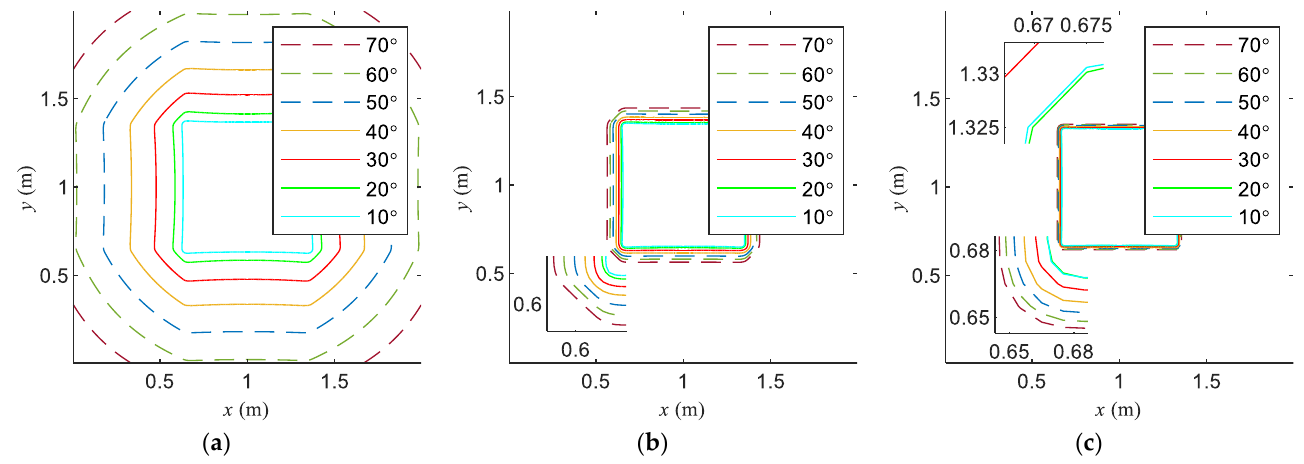
Figure 13. Contour map of Q in a room size of 2 m × 2 m: ( a ) Q = − 10 dB; ( b ) Q = − 20 dB; ( c ) Q = − 30 dB.